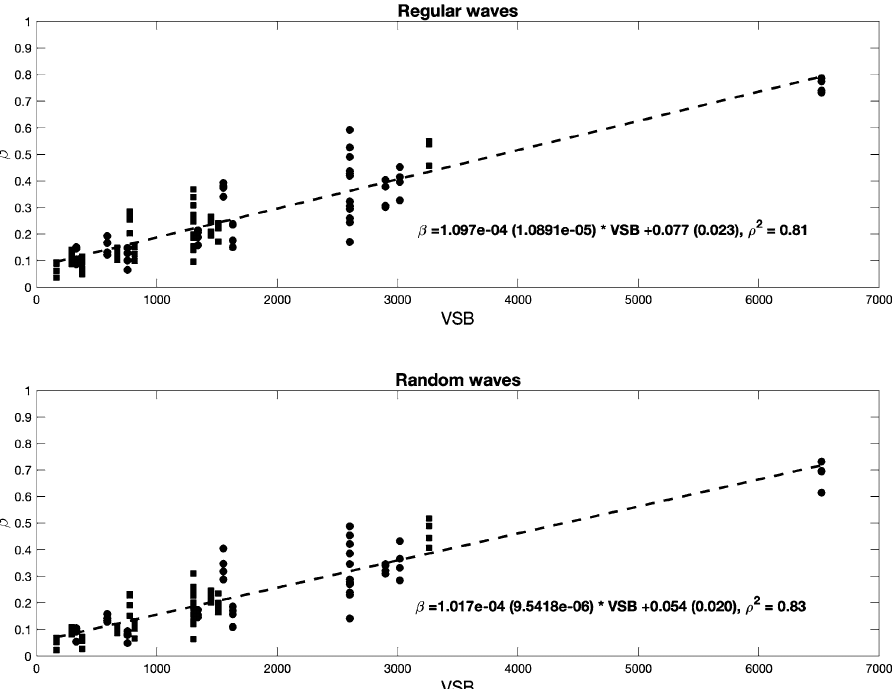
Figure 5. Wave damping coefficient, β , as a function of the volumetric standing biomass, VSB , under all regular (top panel) and random (bottom panel) wave conditions. The obtained linear fitting results are displayed in both panels. 95% confidence interval is shown in brackets and correlation coefficient ( ρ 2 ) for each fit is also displayed.